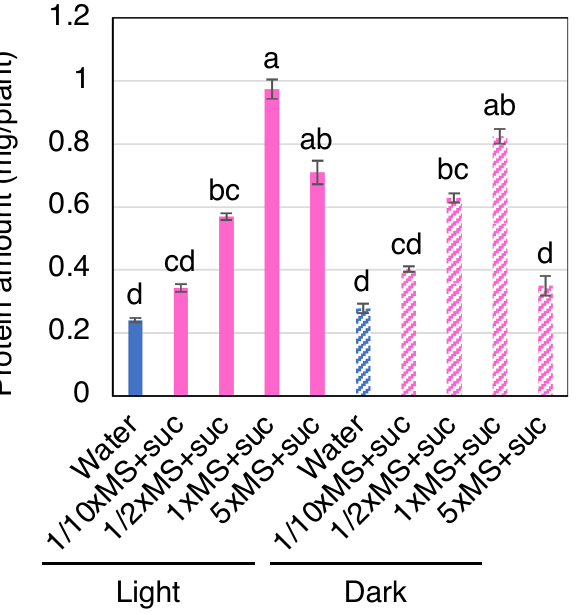
Figure 3. Protein production in rice seedlings using different concentrations of MS medium. The graph shows the total amount of soluble protein extracted from each seedling (n = 5) at 12 DAG in light or in darkness after supplementation with different concentrations of MS medium and 30 g/l sucrose. Different letters indicate significant difference by ANOVA at P < 0.05.